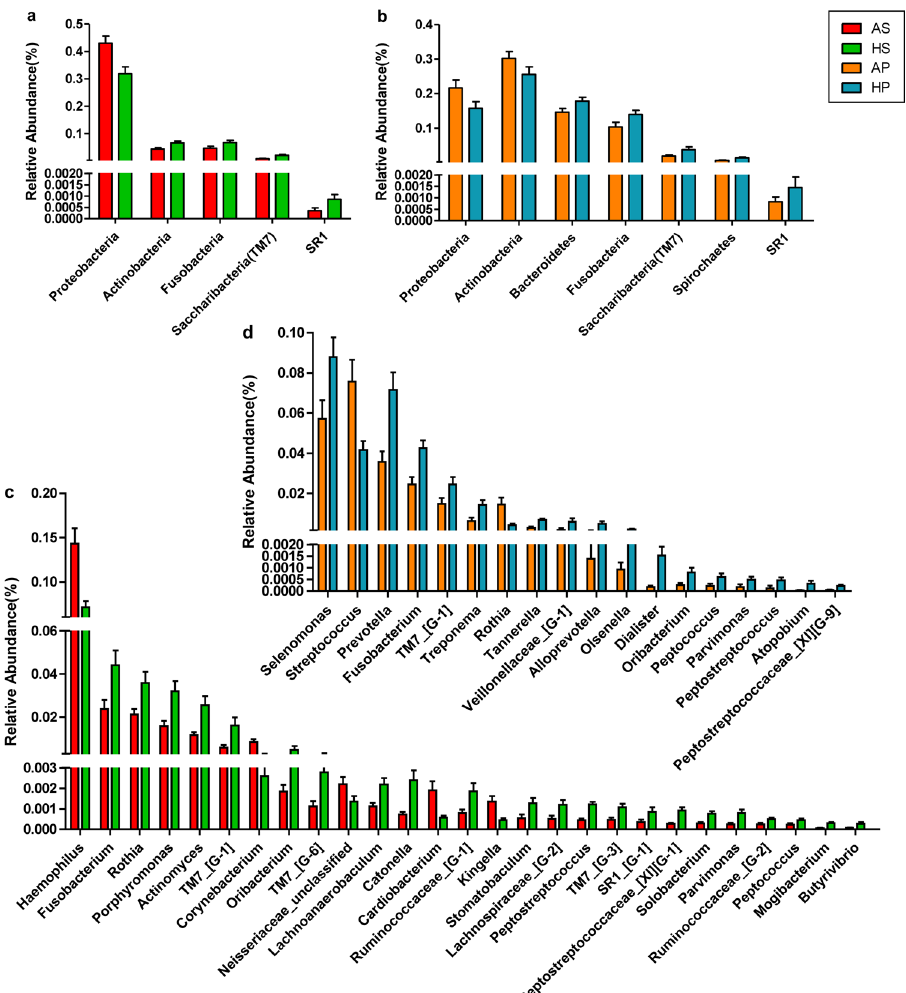
Figure 3. Changes of oral microbiota at the phylum and genus levels between ASD and control subjects. The graphs depict Wilcoxon rank sum test results with p < 0.05 and FDR Q < 0.05 from comparisons of relative abundance between ASD and healthy children at the bacterial phylum level in saliva ( a ) and plaque ( b ) samples. Similar comparisons at the genus level in saliva and plaque samples are shown in ( c ) and ( d ), respectively (p < 0.05 and FDR Q <